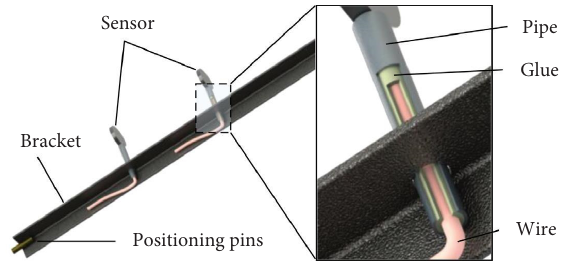
Figure 5: Bracket for the stress sensor.